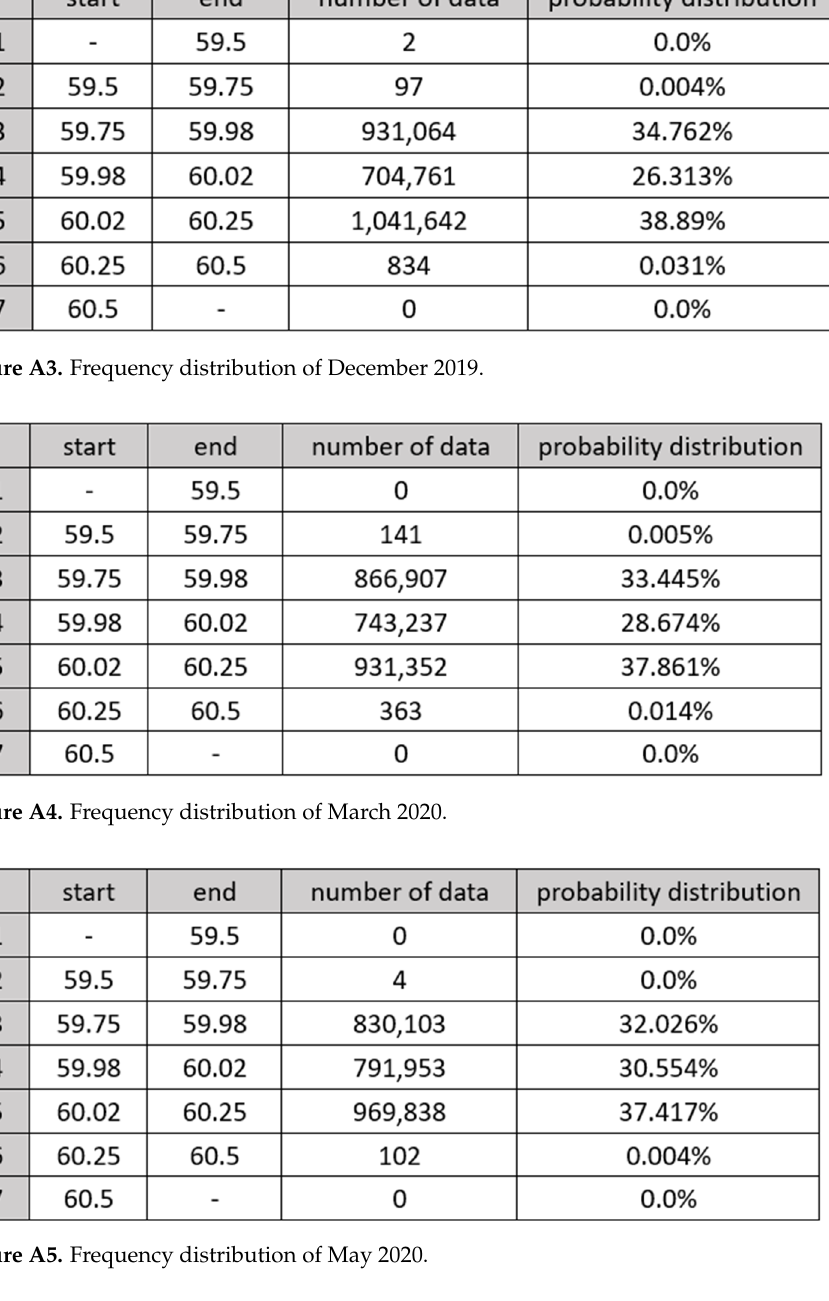
Figure A6. SOC curve and aging features of Scenario 2.